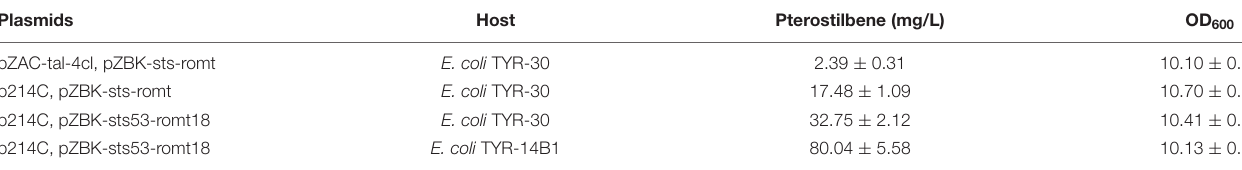
TABLE 2 | De novo production of pterostilbene in E. coli .